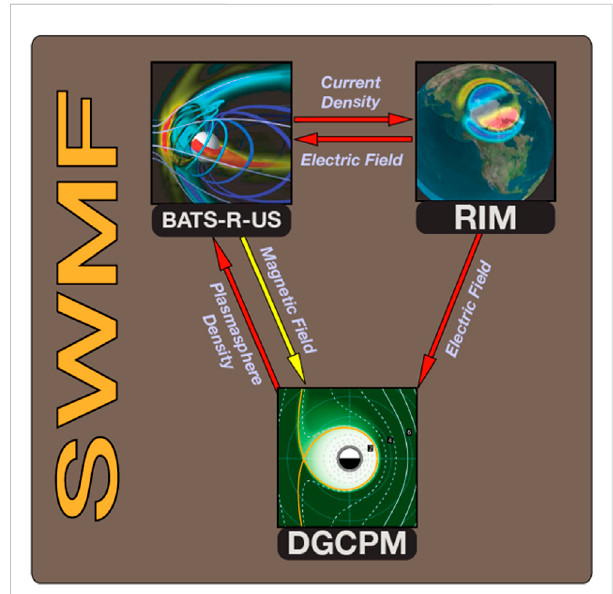
FIGURE 1 Con fi guration of the SWMF and coupling between sub modules. RedarrowsdepictcouplingintheSWMFmodelwhichcurrentlyexists. The yellow arrow depicts coupling to be added to the future, to be discussed